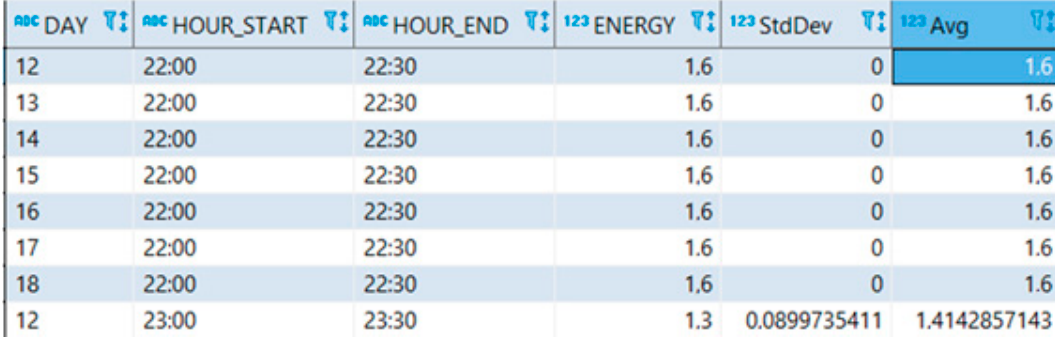
Figure 8. Stage 2. Statistics for raw data on consecutive days.